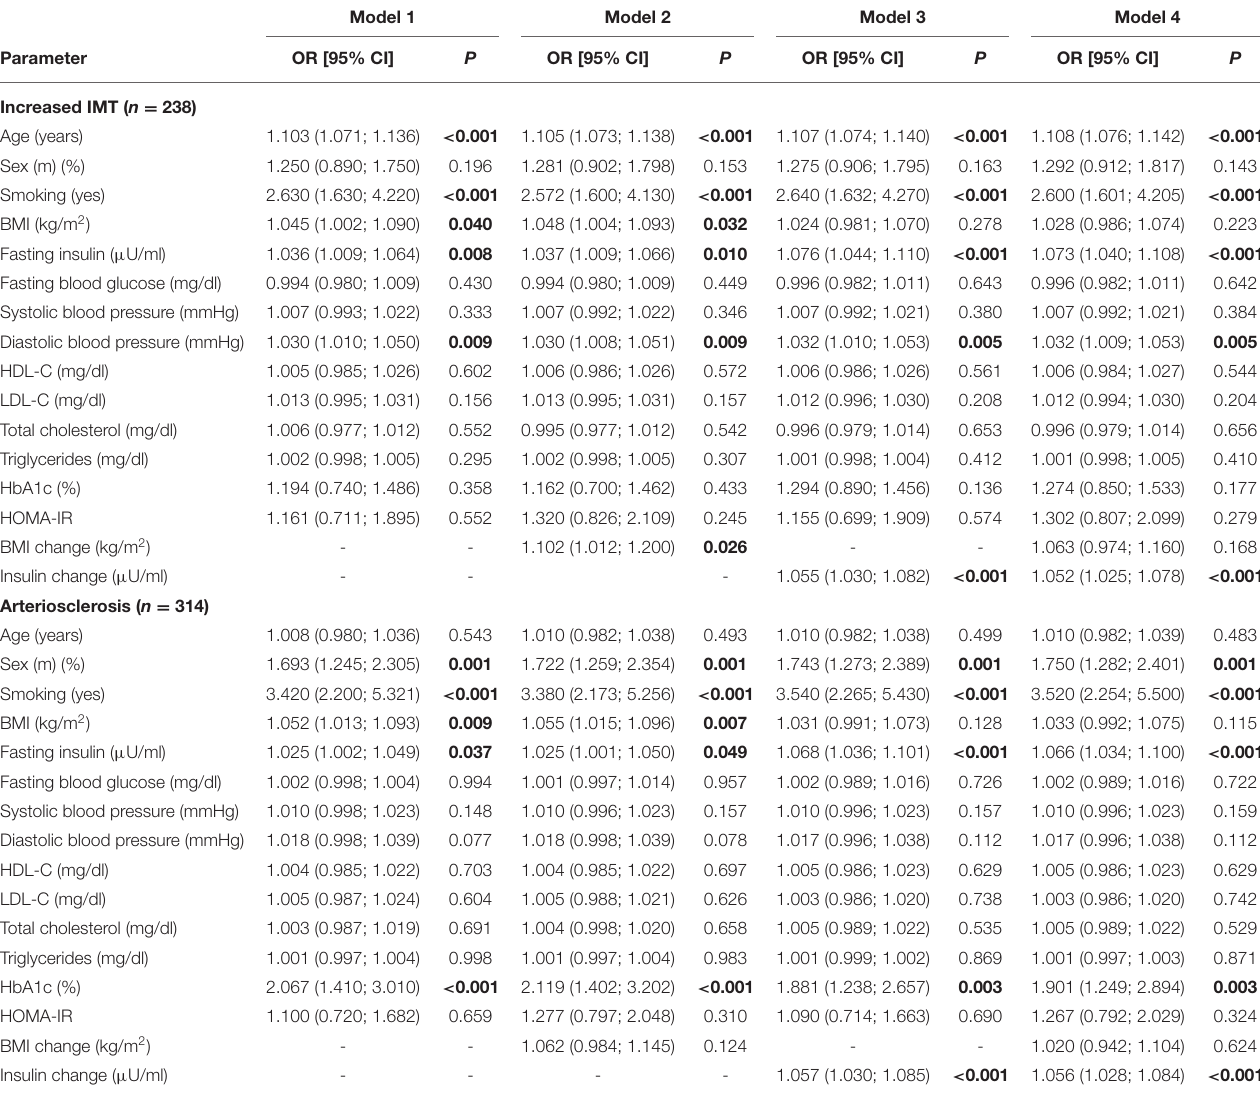
TABLE 2 | Baseline characteristics and changes of BMI and/or fasting insulin during follow-up as risk factors of increased IMT and